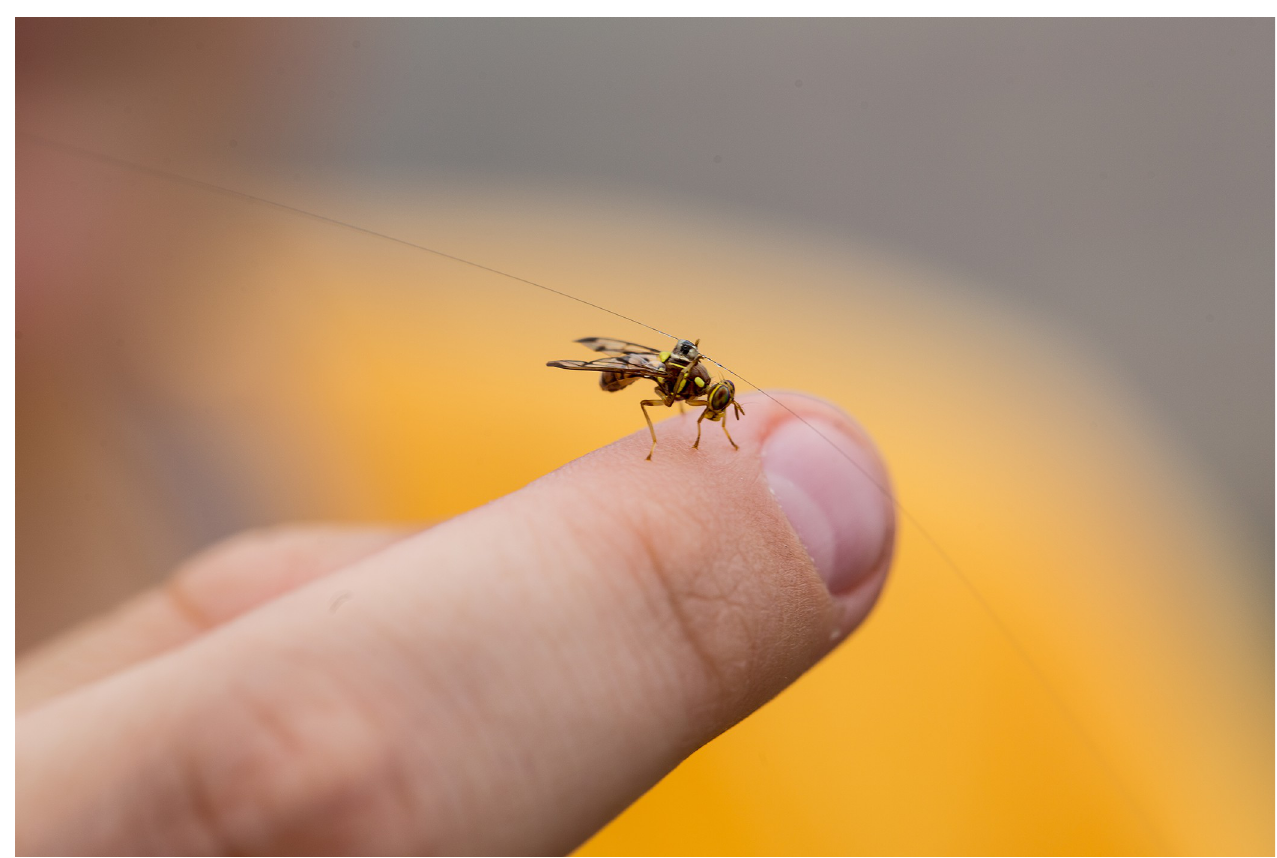
Fig 1. A wild male melon fly, Zeugodacus cucurbitae , with a harmonic radar tag attached. The tag shown weighed approximately 0.8 mg and was fabricated from a diode and superelastic nitinol wire.